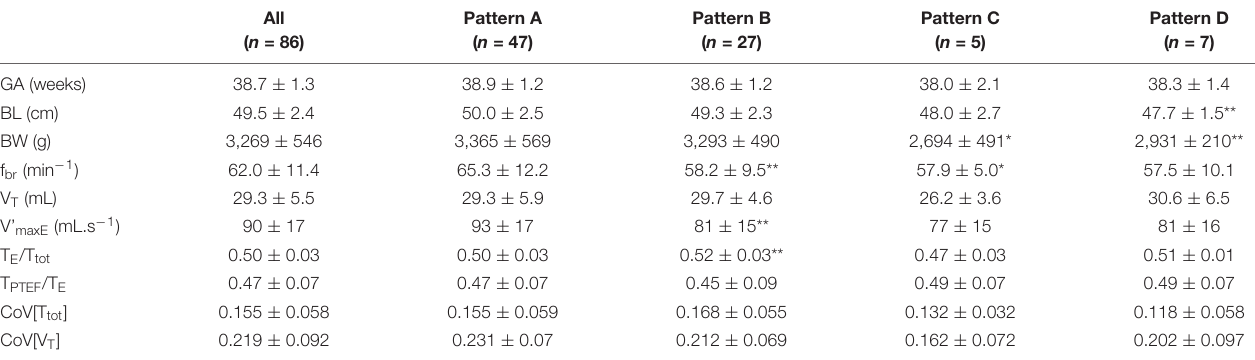
TABLE 1 | Comparison of anthropometry and spirogram data between subject groups of different patterns of flow dependence of reactance.